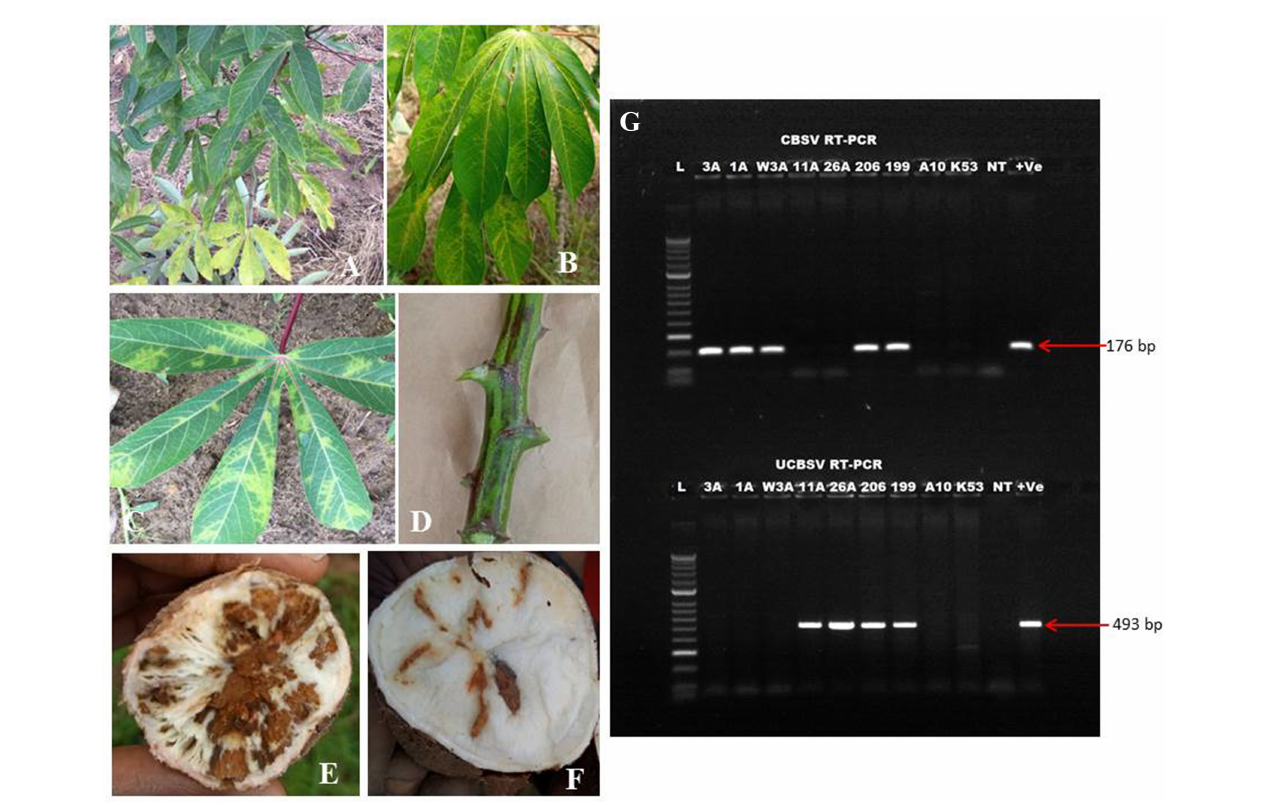
FIGURE2 Symptoms of cassava brown streak disease (CBSD) observed in the field during the surveys in coastal region in Kenya and RT-PCR analysis from representative samples that amplified for CBSV, UCBSV and dual infection. The observed foliar symptoms include severe chlorosis on leaves (A, B) , feathery vein chlorosis (C) . Affected plants may also show brown streaks on stems (D) and root necrosis (E, F) . A gel image of PCR products (G) ; sample 3A, 1A, and W3A represents samples that amplified for CBSV at 176 bp of coat protein region; samples 11A and 26A represents positive samples for UCBSV at 493 bp while samples 206 and 199 represent positive samples for both CBSV and UCBSV indicating dual infection. L; indicates 50 bp Ladder, NT indicates no-template (negative control), + ve indicates a positive control.